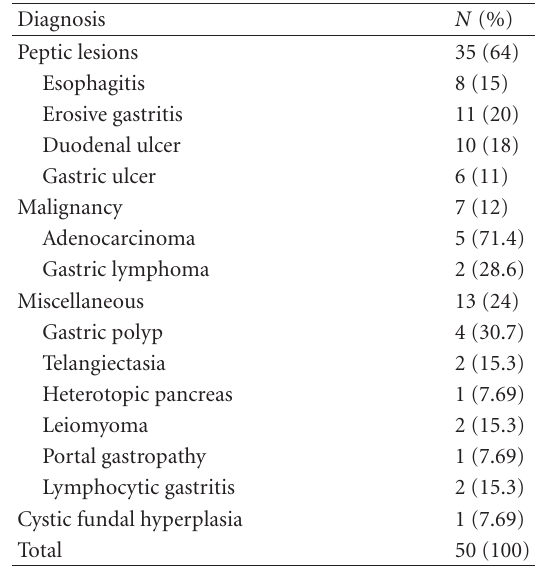
Table 1: Organic causes among the enrolled dyspeptic patients.